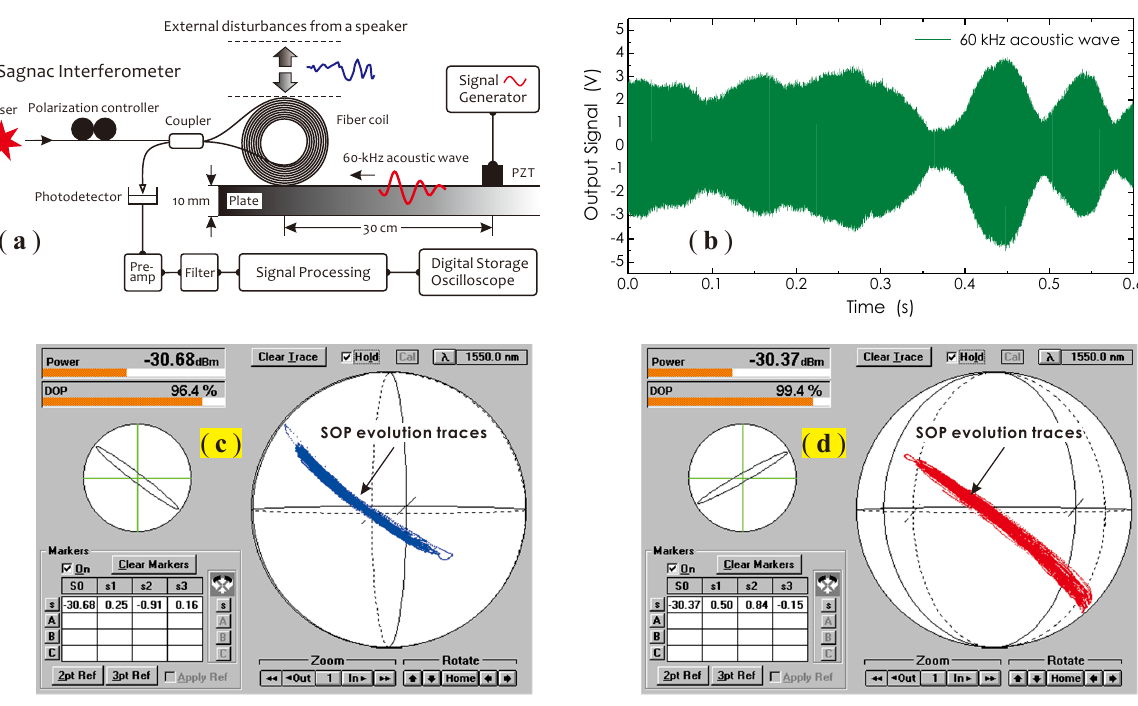
Figure 1. Experimental setup ( a ), the measured waveform ( b ) and SOP variations ( c , d ).